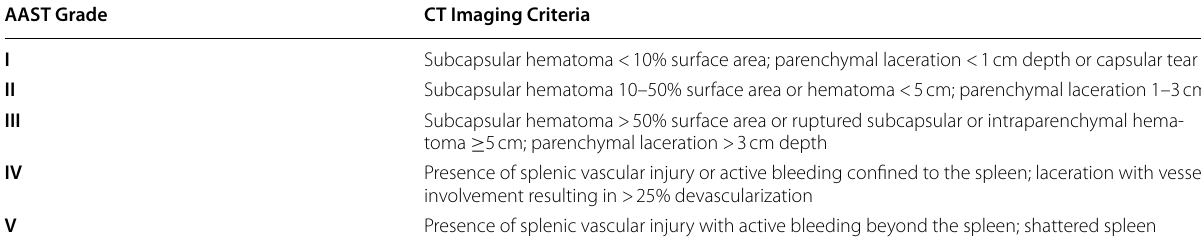
Table 1 Summary of 2018 AAST spleen injury scale for CT Findings AAST